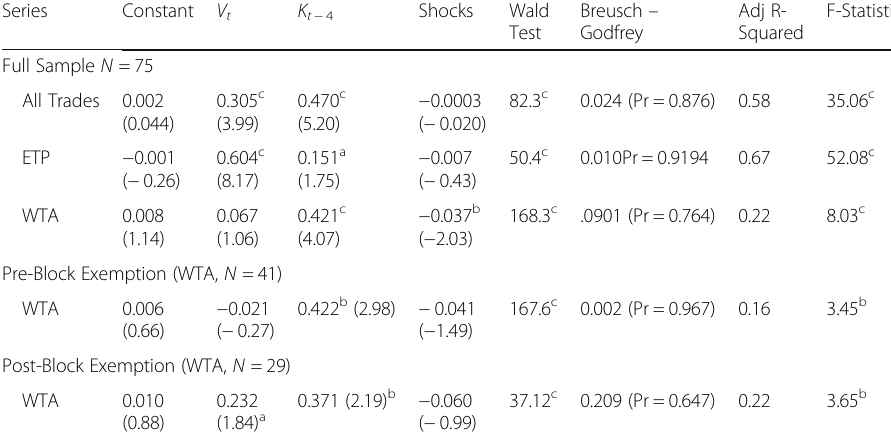
Table 3 Adaptive expectations – OLS estimates - equation in first differences Series Constant V t K t − 4